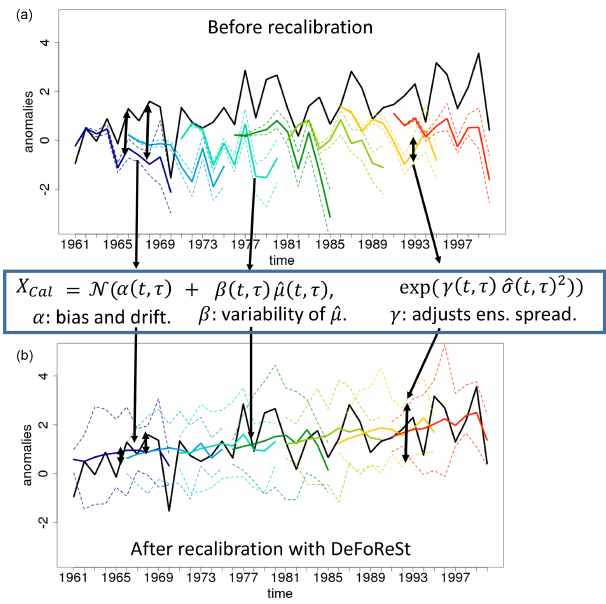
Figure 1. Schematic overview of the effect of DeFoReSt for an ex- emplary decadal toy model with ensemble mean (colored lines), en- semble minimum/maximum (colored dotted lines) and associated pseudo-observations (black line). Note that different colors indicate different initialization times. Before recalibration (a) , the ensem- ble mean shows a lead-time-dependent mean or unconditional bias (drift) which is tackled by α(t,τ) . Moreover, the ensemble mean ˆ µ exhibits a conditional bias, i.e., that the variances of ˆ µ and obser- vations disagree. This is tackled with β(t,τ) . Decadal predictions can also be over- or underdispersive, i.e., that the ensemble spread over- or underestimates the error between observations and ensem- ble mean. This example shows an overdispersive forecast. Within DeFoReSt, the coefficient γ(t,τ) accounts for the dispersiveness of the forecast ensemble. Panel (b) shows the exemplary decadal toy model after applying DeFoReSt with the inherent corrections of lead- and start-time-dependent unconditional bias, conditional bias and